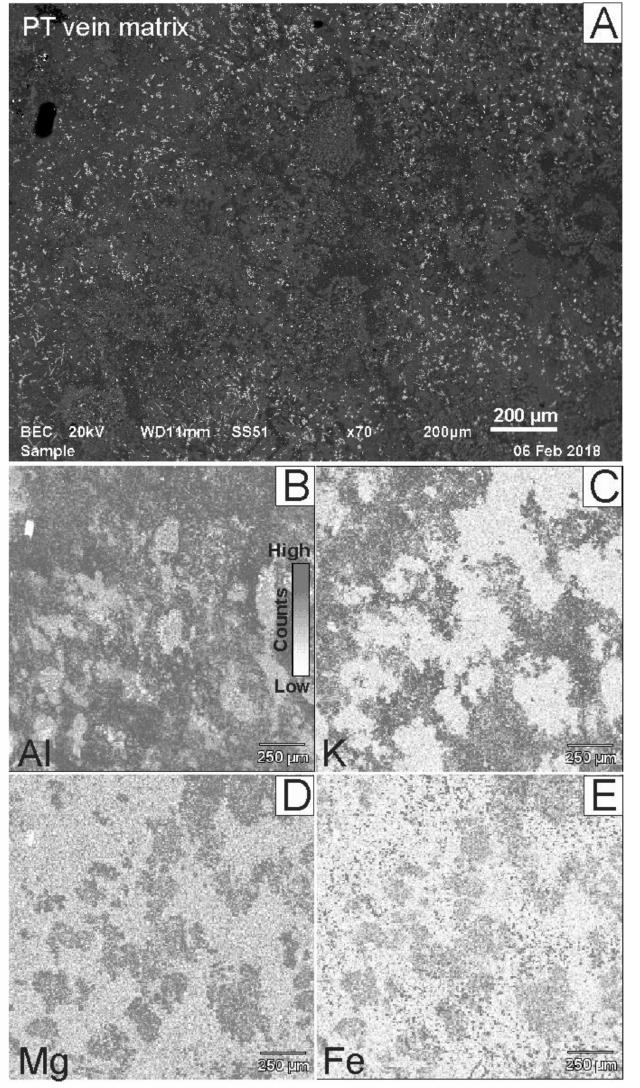
Figure 8. BSE image and EDX maps of the PT vein’s matrix. ( A ) BSE image. ( B ) EDX intensity map of Al, showing its inhomogeneous distribution. ( C ) EDX intensity map of K, showing its patchy, inhomogeneous distribution. ( D ) EDX intensity map of Mg, showing its inhomogeneous distribution, negatively correlating with K. ( E ) EDX intensity map of Fe, showing its inhomogeneous distribution, positively correlating with